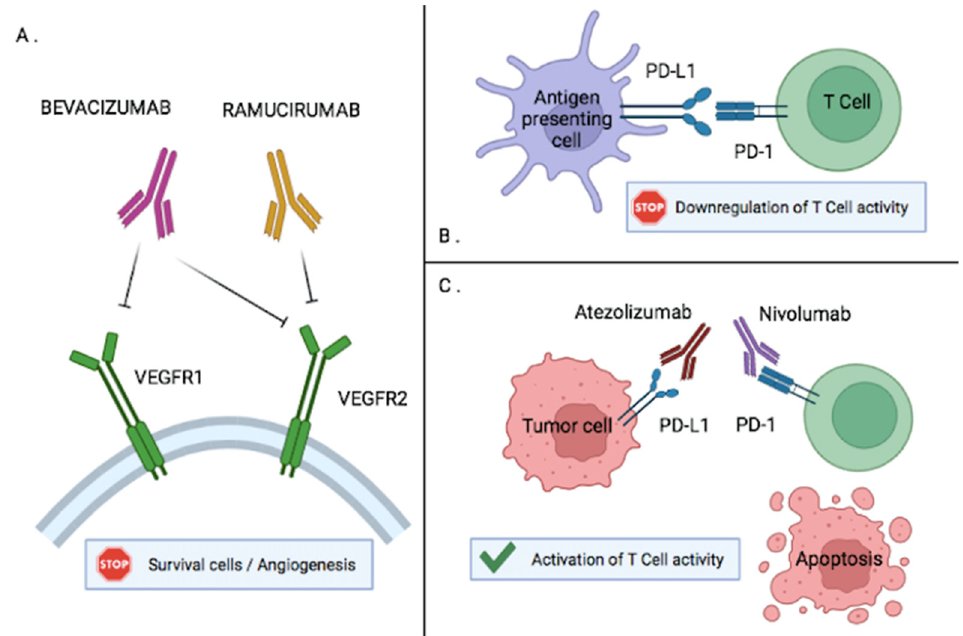
Figure 2. ( A ). Anti-VEGF and monoclonal antibody (ramucirumab) inhibit angiogenesis in